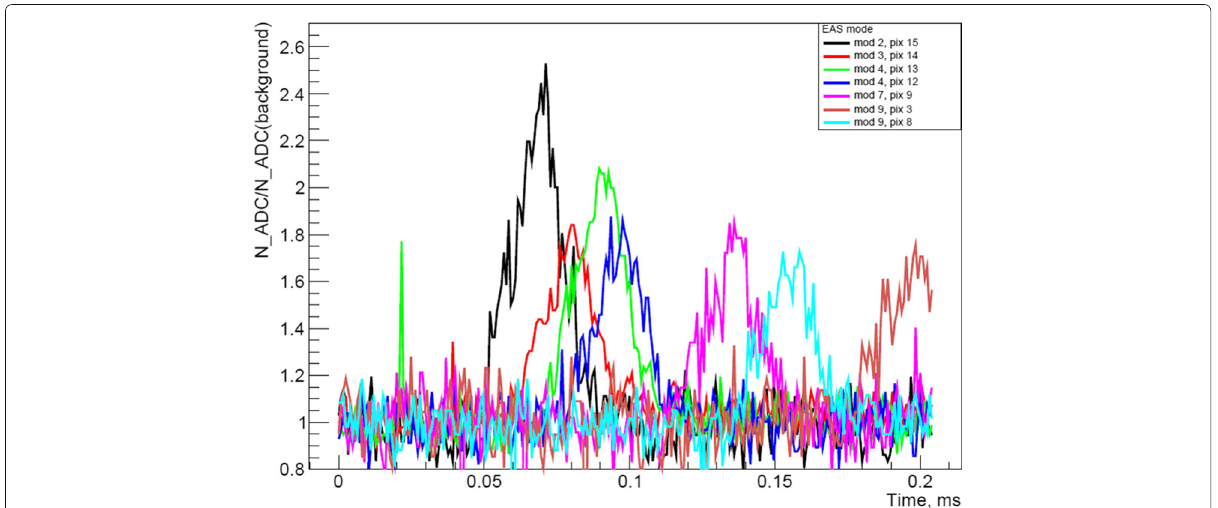
Fig. 3 Waveforms of several hit pixels of the elves type event registered on September 18, 2016 above continental Africa. The Y -axis is a ratio of ADC counts and background signal for each pixel